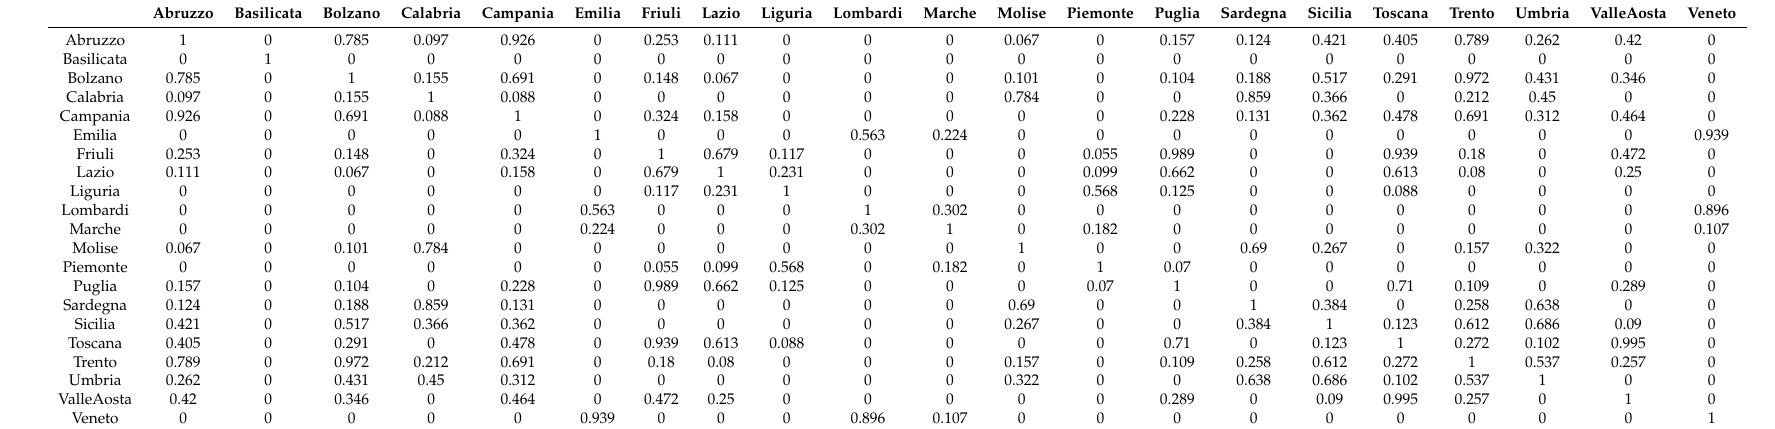
Table A43. Similarity values of Deceased network in the study period.